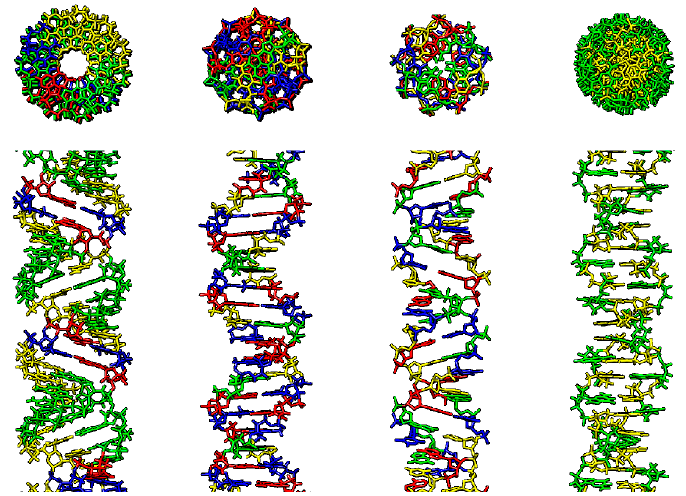
Figure 1. Various double-stranded DNA conformations, right-handed: A-DNA, B-DNA, C-DNA, left-handed: Z-DNA (from left to right). First row–upper view, second row–side view. A-DNA– AGGGGCCCCT repeat, B-DNA–random sequence, Z-DNA–CG repeat. Visualized using Chimera software, A–blue, C–yellow, G–green, T–red.